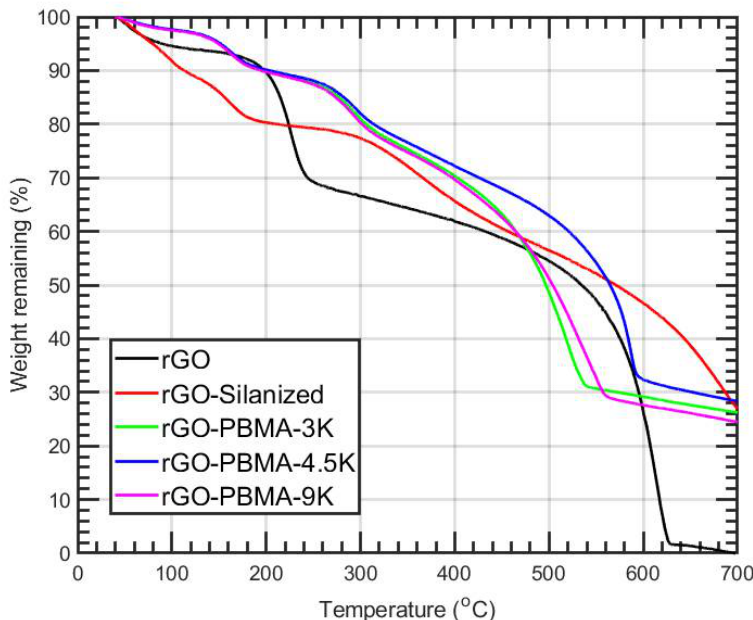
Figure 1. TGA thermograms of reduced graphene oxide (rGO), after silanization (rGO-Silanized), and after subsequent polymer grafting (rGO-PBMA). PBMA = poly( n -butyl methacrylate).